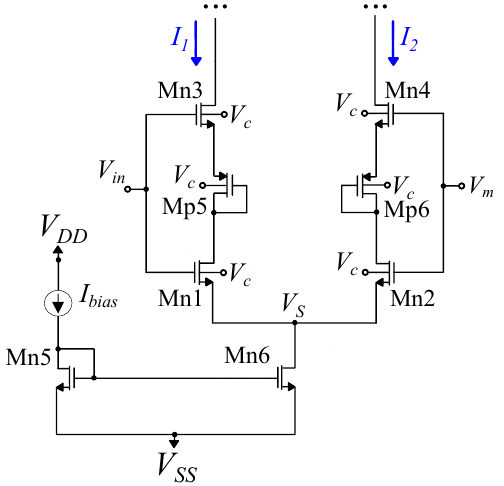
Figure 15. Transistor level implementation of a versatile differential